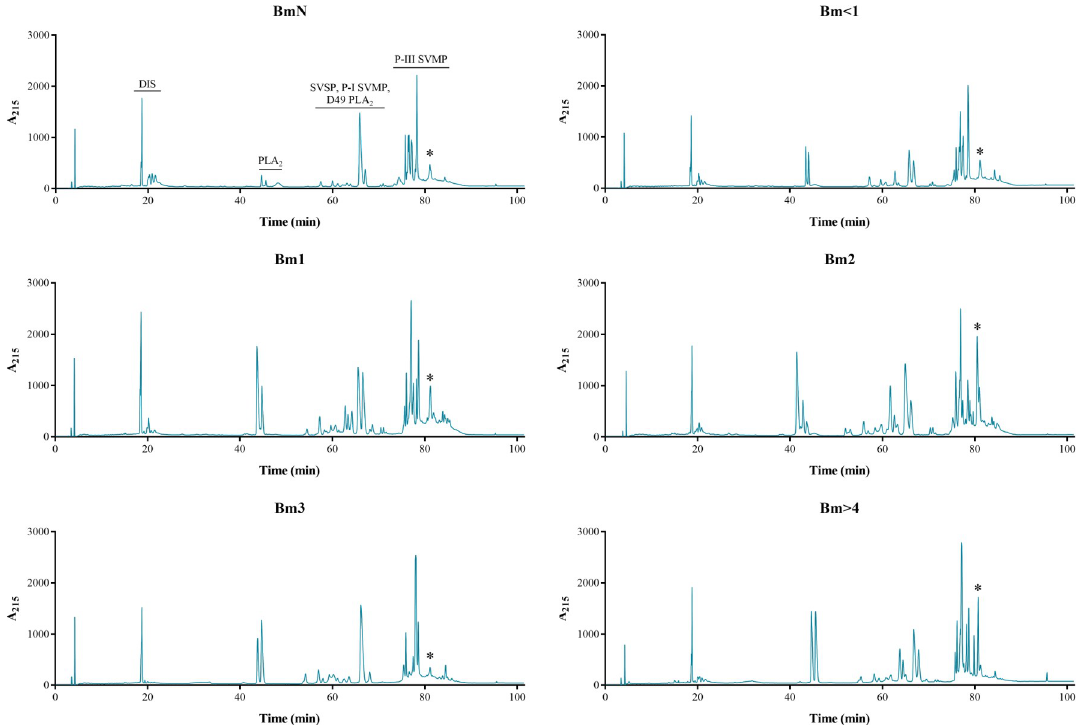
Fig 3. Venom profile of male B . moojeni at different ages by RP-HPLC. Samples of 500 μ g of lyophilized venom were dissolved in 0.1% trifluoroacetic acid (TFA; solution A) and submitted to RP-HPLC in a C18 column. Elution was carried out at 1 mL/min by applying a solution B (95% acetonitrile containing 0.1% TFA) gradient: 5% for 5 min; 5–25% for 10 min, 25–45% for 60 min, 45–70% for 10 min, 70–100% for 10 min, and 100% for 10 min. Absorbance was measured at 215 nm. � : marked peak that may be related to collagenolytic activity. DIS: disintegrin; PLA 2 : phospholipase A 2 ; SVSP: snake venom serine protease; SVMP: snake venom metalloprotease.